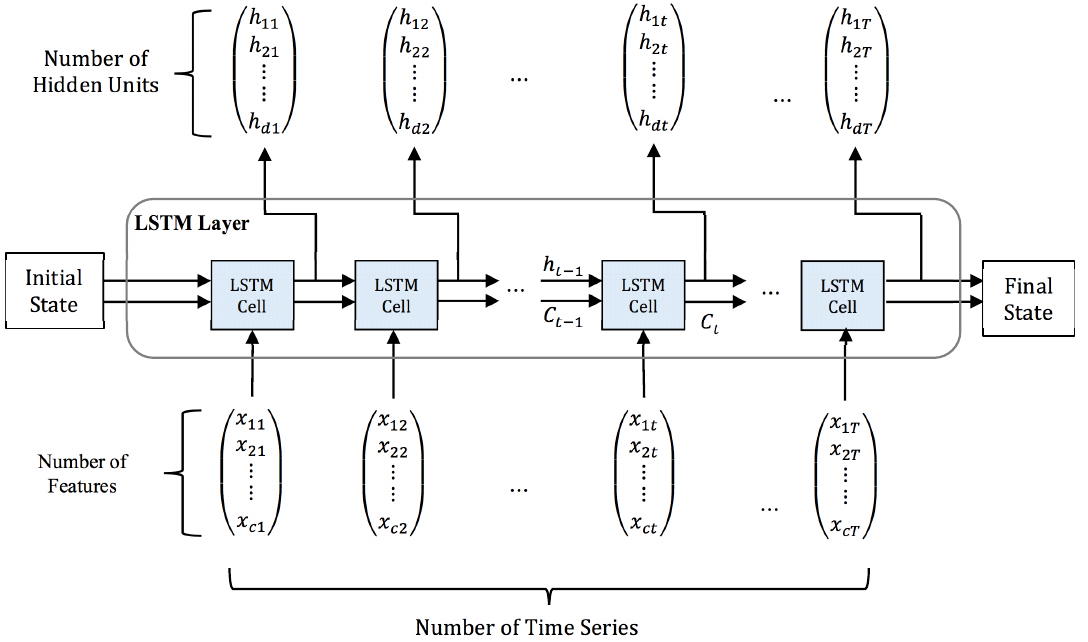
Figure 7. Illustration of the LSTM network used in the